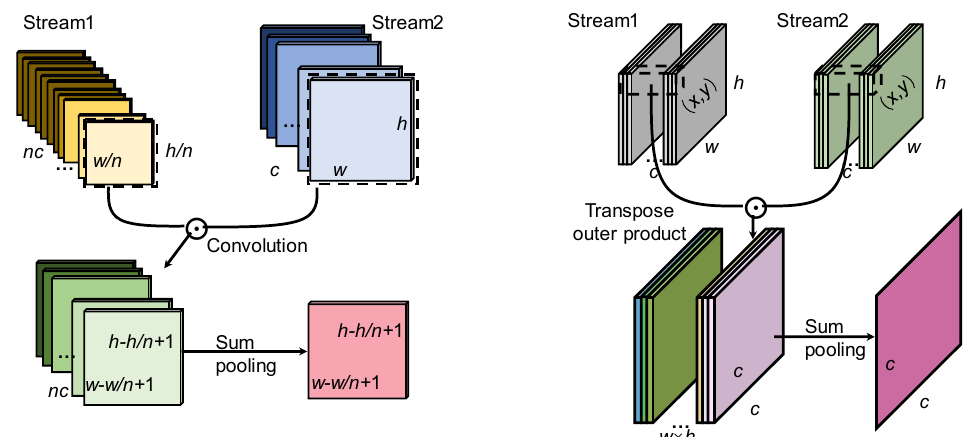
(b) Traditional 2nd-order bilinear feature generation Figure 4. The generation of cross-flow spatial interactive feature. ( a ) The generation of proposed spatial interactive feature; ( b ) traditional second-order feature generation.